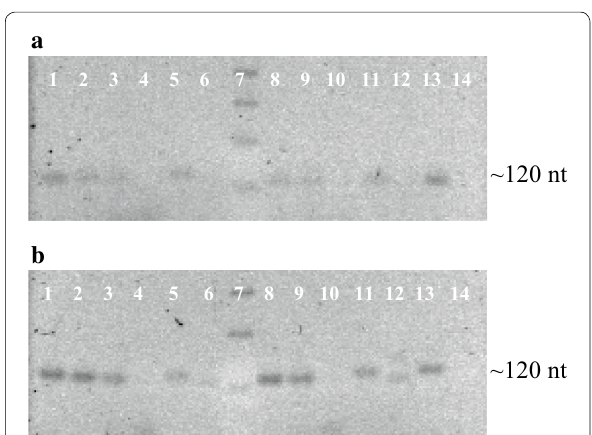
Fig. 6 Analysis of the transcription of A. brasilense Sp7 phasin genes. RT‑PCR assays of the internal region of putative phasin genes were conducted using cDNA of wild type ( A. brasilense Sp7) and mutant ( A. brasilense Δ phaP1 ) strains. RNA was extracted from cultures grown on minimal medium containing malic acid and ammonium chloride at C:N ratios of 30:1 and 90:1. Transcripts were visualized on a 3% agarose gel electrophoresis. a Transcription analyses of putative phasin genes of wild type and mutant strains grown at a C:N ratio of 30:1. For wild type: phaP1 (lane 1), phaP2 (lane 2), phaP3 (lane 3), phaP4 (lane 4), phaP5 (lane 5), phaP6 (lane 6). GeneRuler 1 Kb DNA ladder ThermoScientific (lane 7). For mutant strain: phaP2 (lane 8), phaP3 (lane 9), phaP4 (lane 10), phaP5 (lane 11), phaP6 (lane 12). 16S rRNA was used as positive control (lane 13). Negative control using cDNA of mutant strain with gene‑specified primers for phaP1 transcript was done (lane 14). b Transcription analyses of putative phasin genes in wild type and mutant strains grown at a C:N ratio